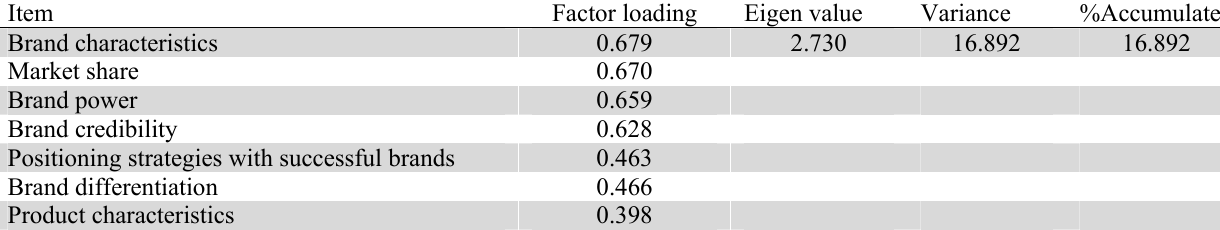
The summary of various components associated with brand power Item